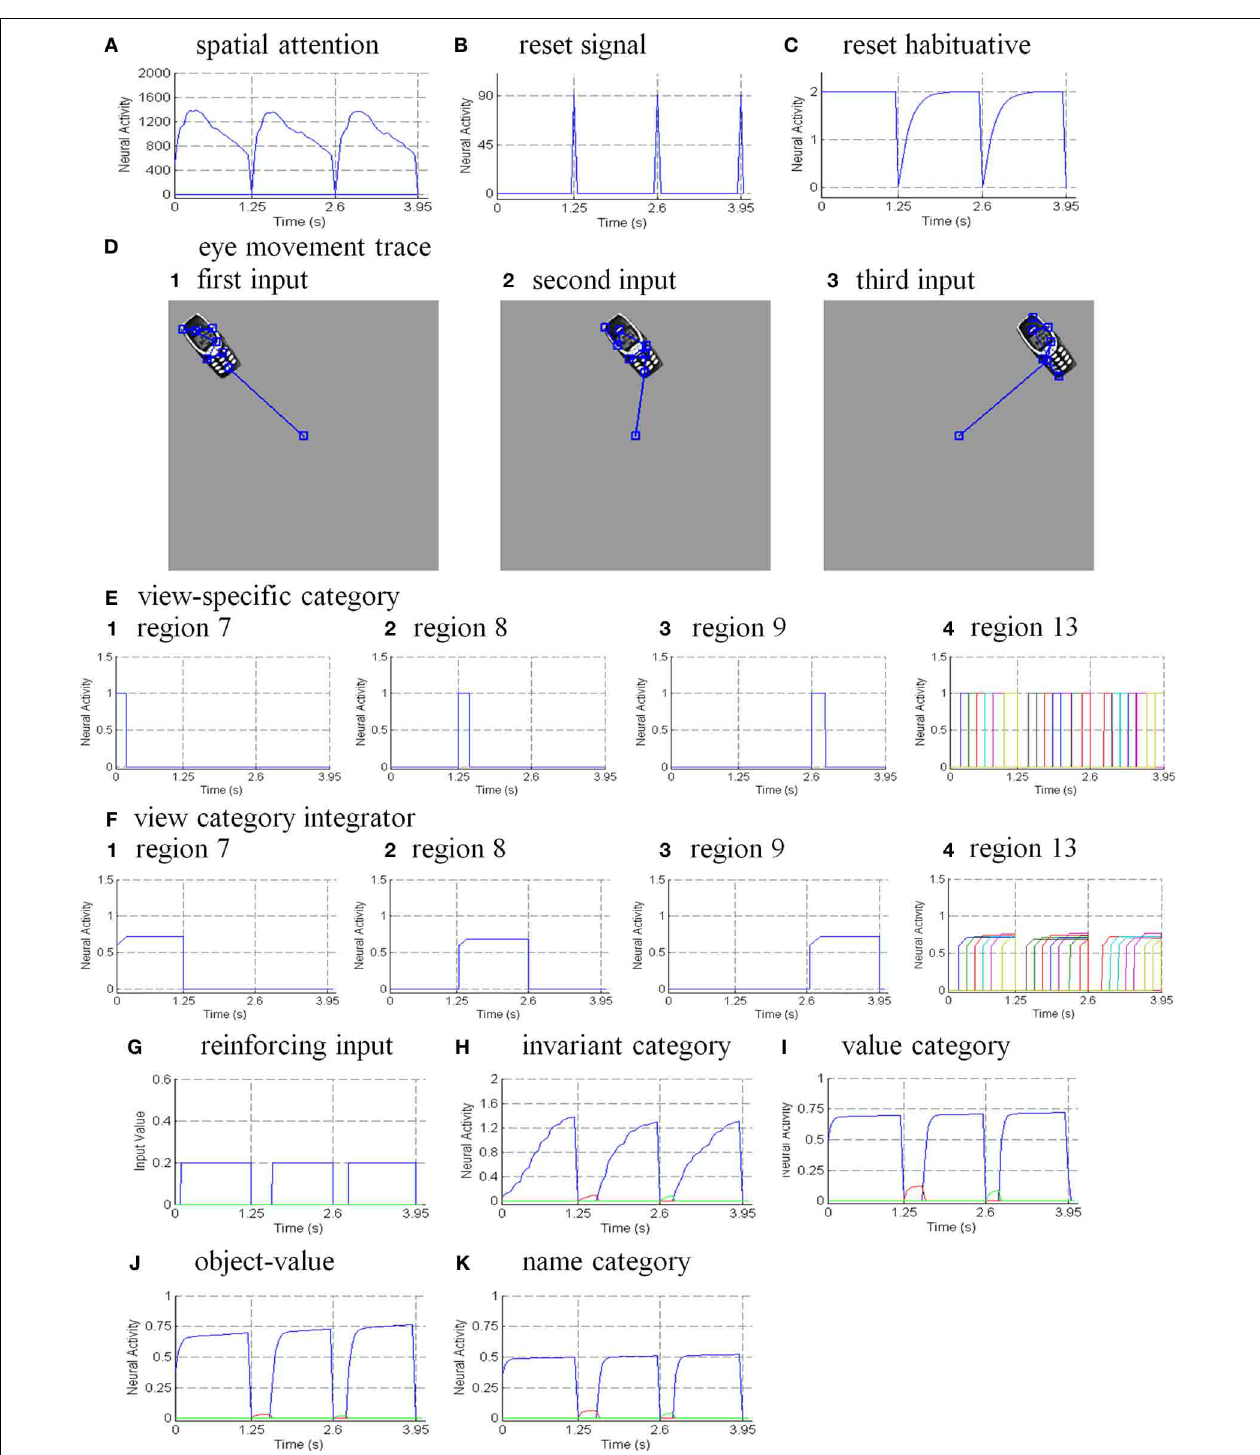
FIGURE 12 | Model simulations of positionally- and view-invariant cellphone object category learning, after 10 reinforcement simulation trials. Model receives a sequence of three simulated scenes. Each scene contains a single cellphone placed at different positions (see Figures 8E–G ), and the initial eye fixation is located at the center of the scene. Before the object is brought to the foveal region by a saccadic eye movement, a view